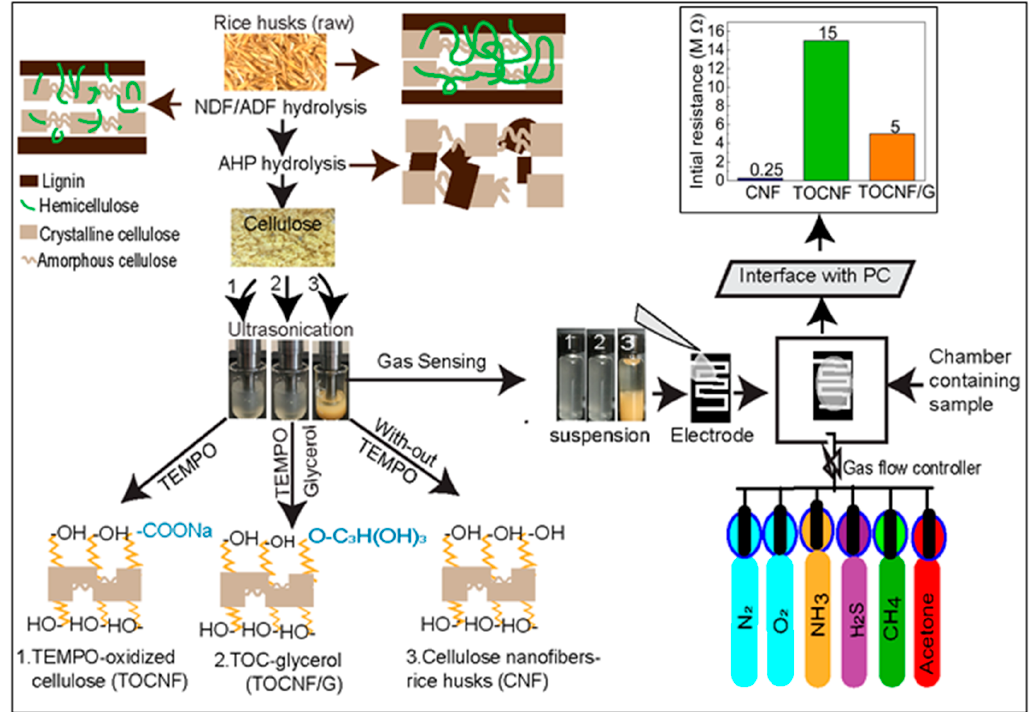
Figure 2. Schematic representation of cellulose nanofibers and TEMPO-oxidized cellulose modification process from rice husks ( left ) and fabrication of self-standing nanocellulose film from extracted cellulose nanofibers (CNF), TEMPO-oxidized cellulose (TOCNF), and TOCNF with glycerol (TOCNF/G) against various water-soluble gases with their initial resistance ( top right ).